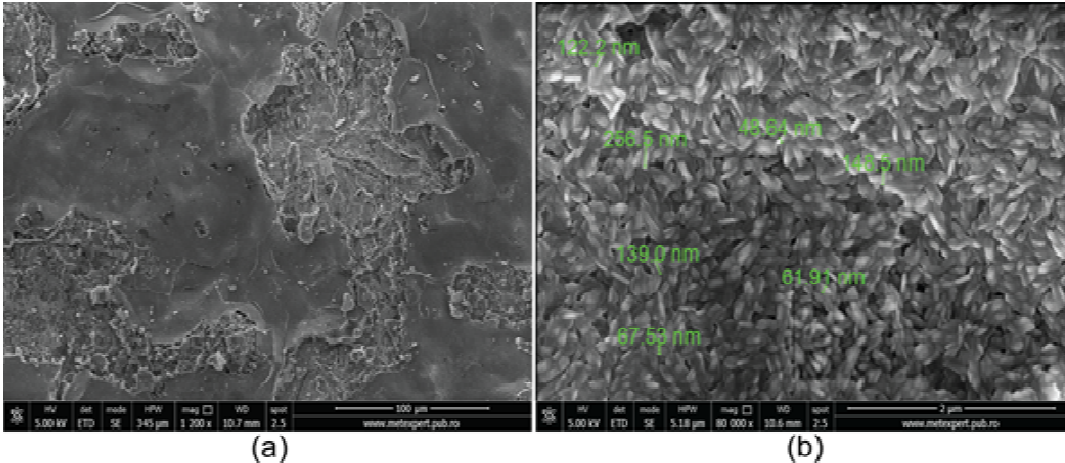
Figure 4. SEM morphology of the CoCrFeMnNi film electrodeposited at −2.1 V for 90 min: ( a ) ×1200; ( b ) ×80000.